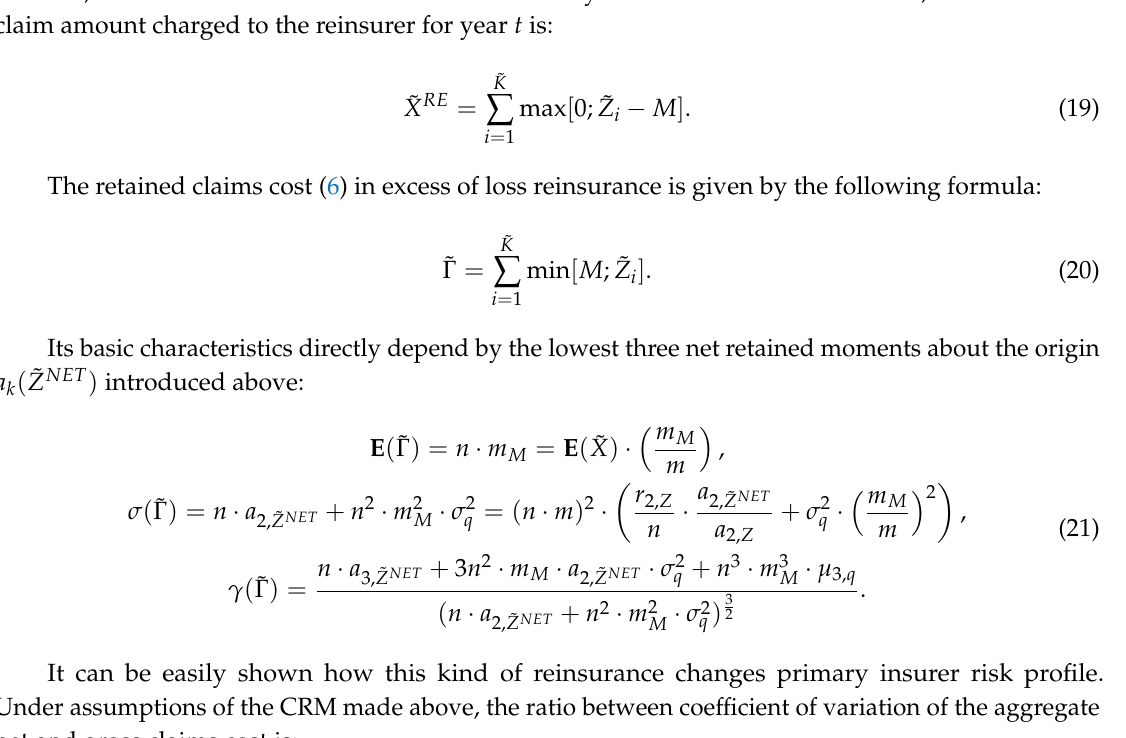
Figure 2. Gross-to-net a factor k